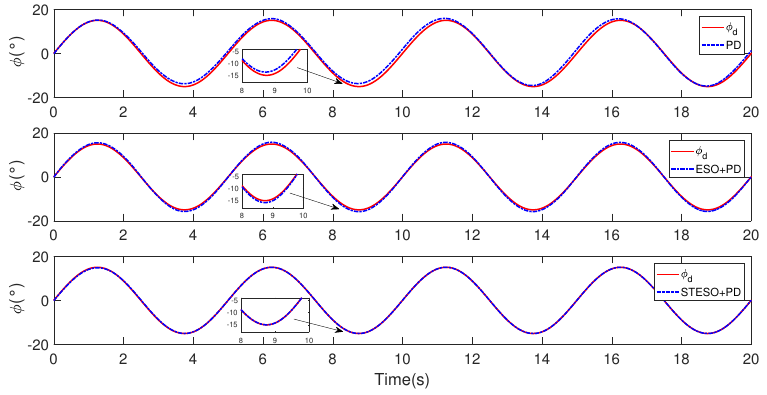
Figure 3. Simulation curves of φ in Case A.